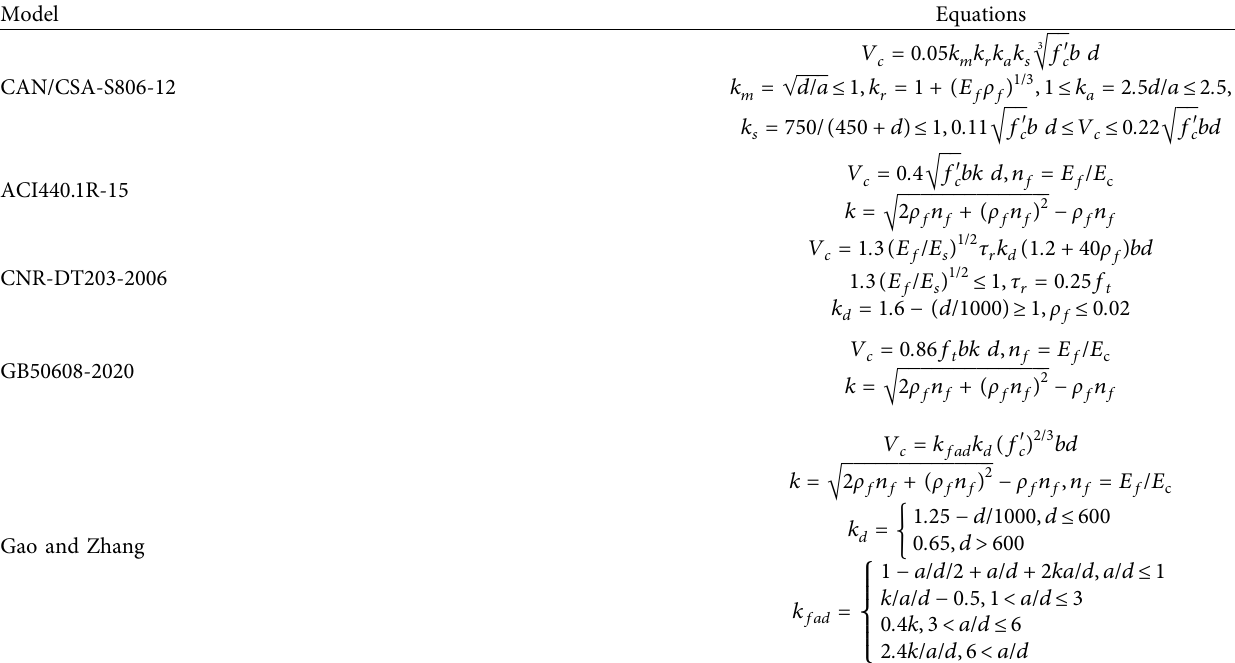
Table 1: Models for the shear capacity of FRP bar reinforced concrete beams without web reinforcement.